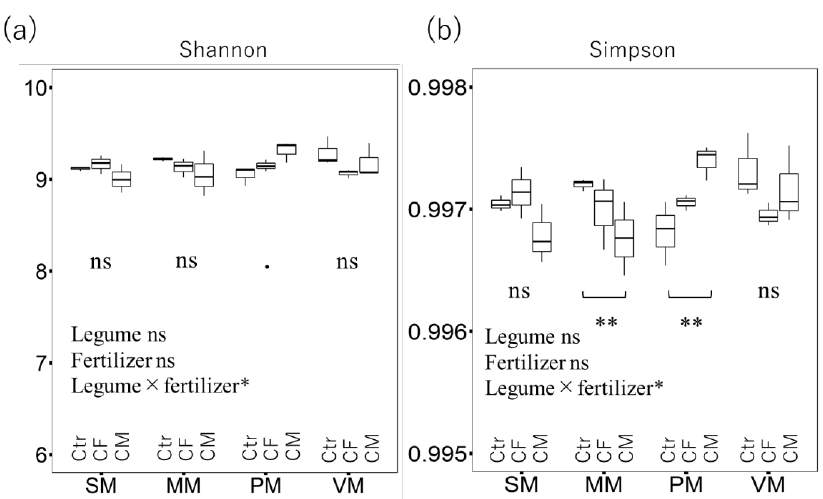
Figure 1. Box plot of bacterial OTUs alpha diversity indicating ( a ) the Shannon’s Index and ( b ) the Simpson’s index. Two-way ANOVA and Tukey–Kramer’s pairwise comparison were performed on the calculated alpha-diversity indices: p < 0.25, * p < 0.05, and ** p < 0.01. The abbreviations of legume treatments were as follows: single maize, SM; maize cropped with velvet bean, MM; maize cropped with common bean, MP; maize cropped with cowpea, VM. Fertilizer treatments were abbreviated as no fertilizer, Ctr; chemical fertilizer, CF; carbonized chicken manure, CM.